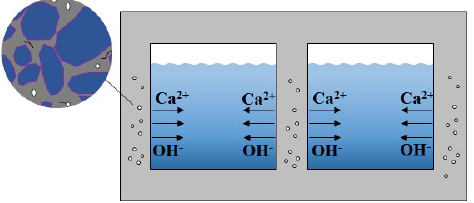
Figure 1. Schematic diagram of the concrete dissolution